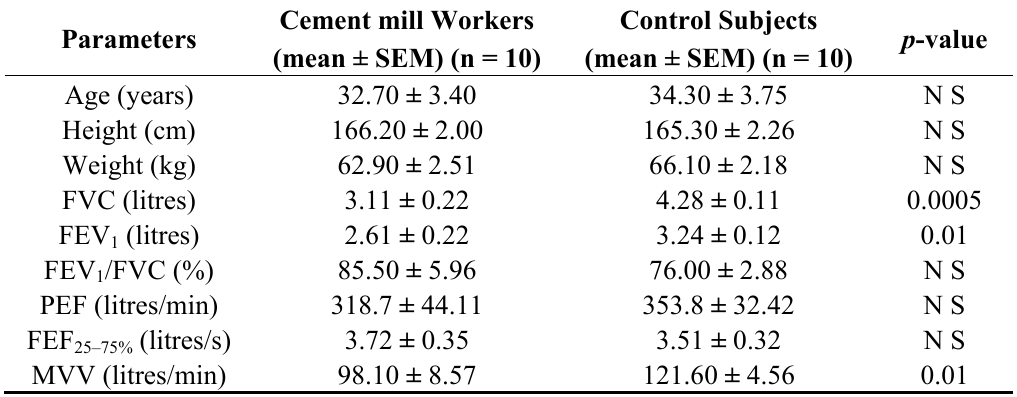
Table 2: Anthropometric and lung function data for cement mill workers with duration of exposure 5–10 years compared with their matched